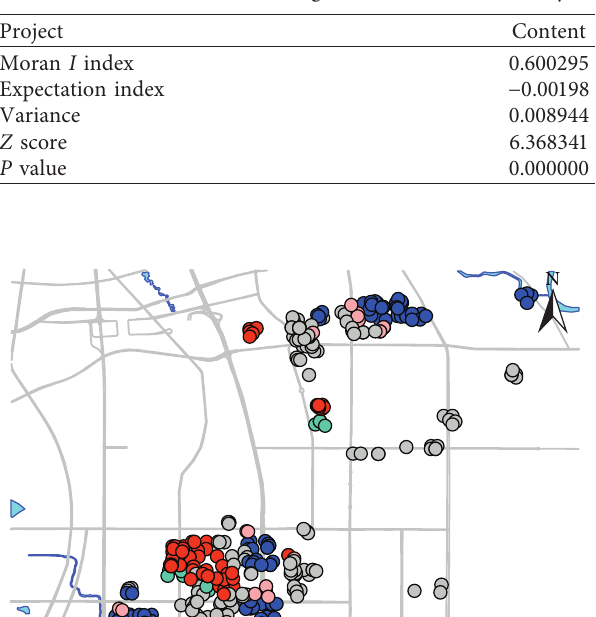
Table 2: Moran’s I index table of global autocorrelation analysis.